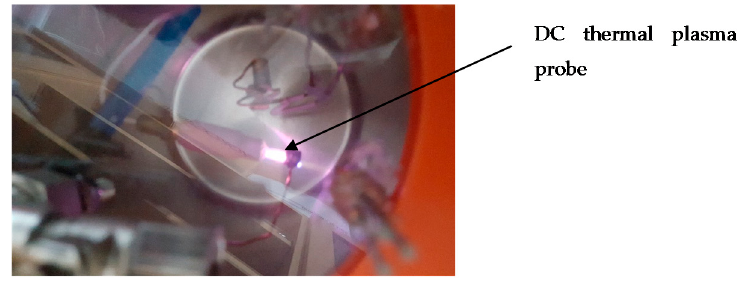
Figure 8. DC thermal plasma emissions at vacuum pressure.